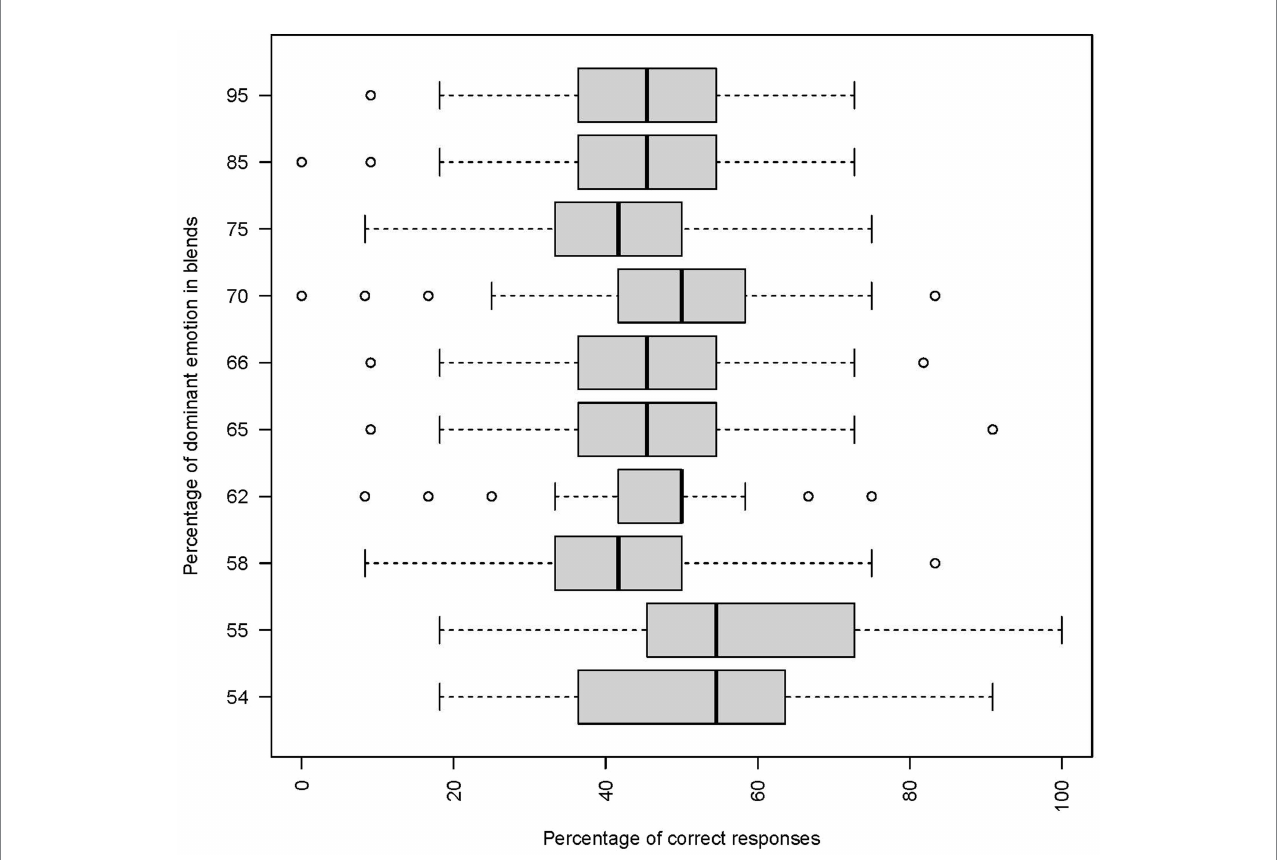
FIGURE 4 Percentage of correct responses as a function of percentage of the dominant emotion in emotion blends.